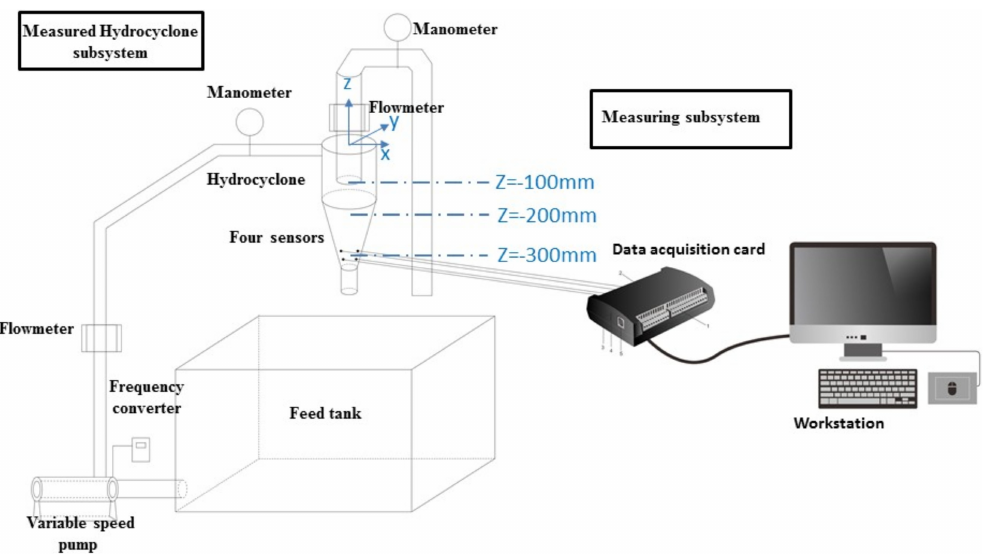
Figure 1. Diagram of experiment rig. Table 1. Structures and operations of the